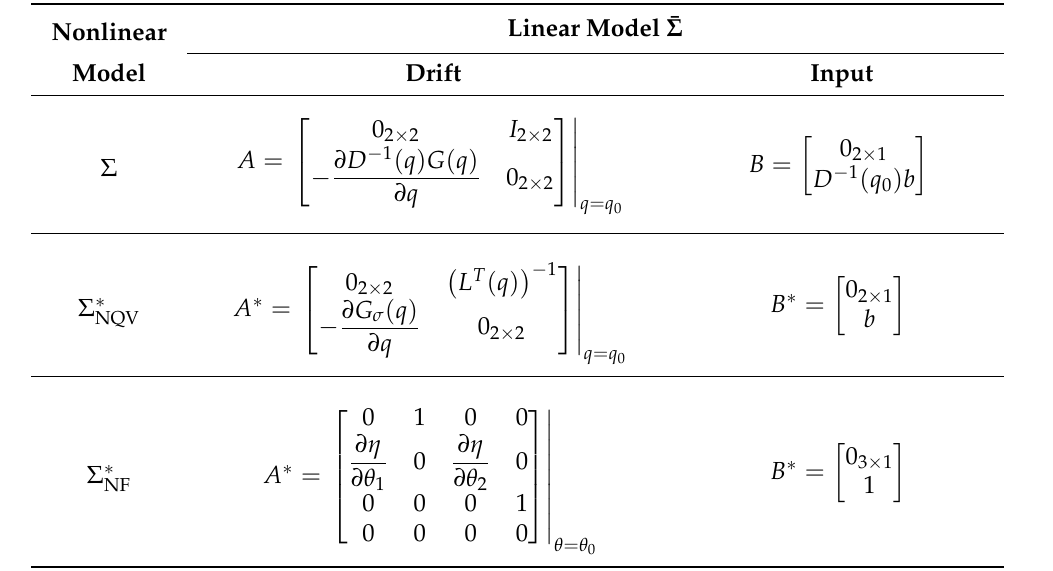
Table 2. Approximated models of nonlinear equivalent systems describing Pendubot